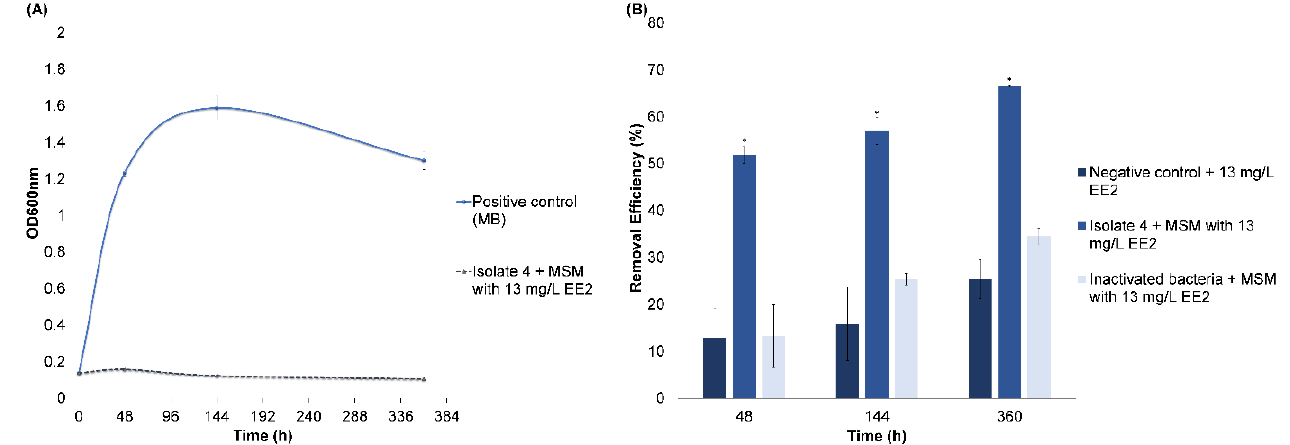
Figure 5. Representation of the bacterial growth curve ( A ) and removal efficiency in percentage ( B ) in the presence of EE2 over 360 h of assay. Asterisks indicate a significant difference compared to the control at p < 0.05 *. Values are expressed as the mean ± standard error (n = 3).